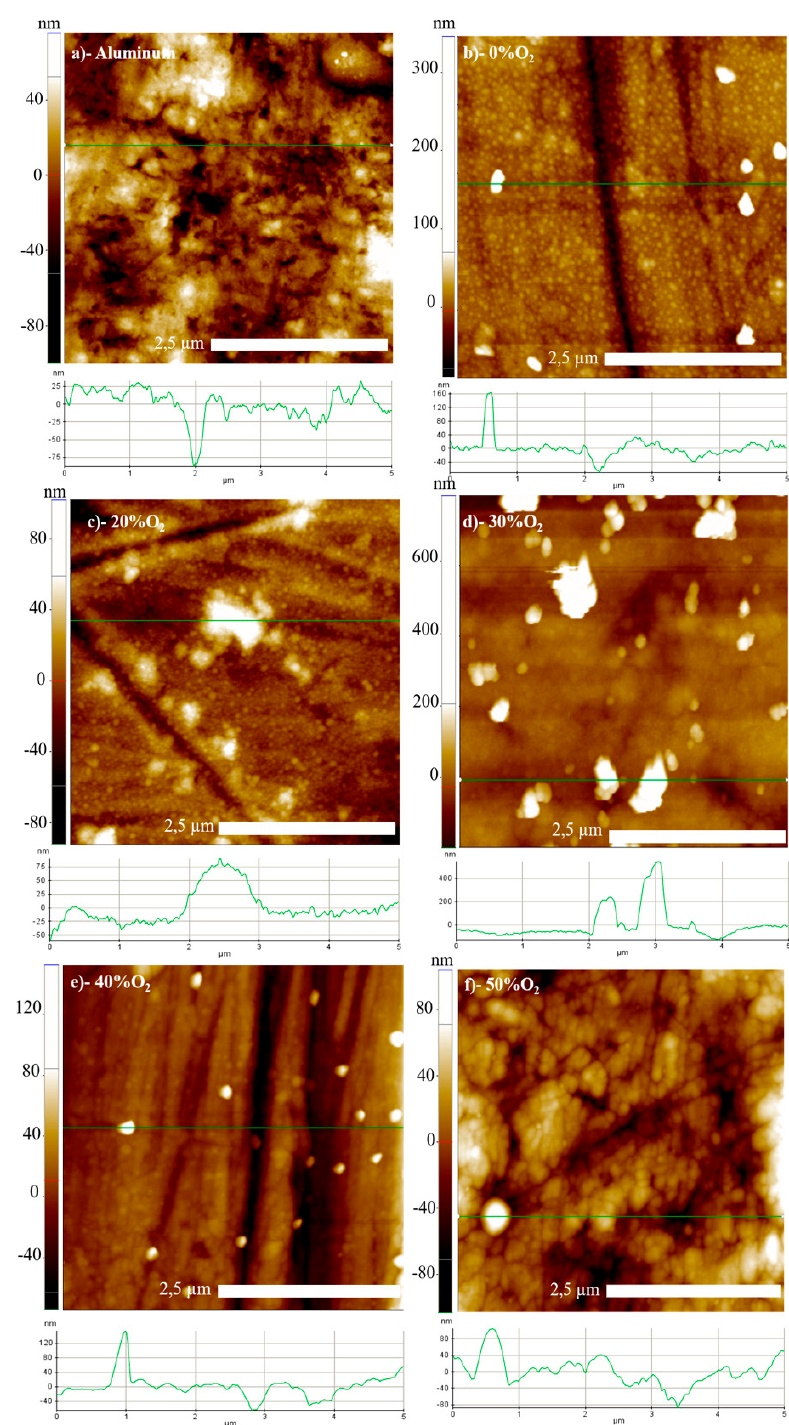
Figure 5. Topographic profiles of samples deposited on polished aluminum plates in plasmas containing different proportions of